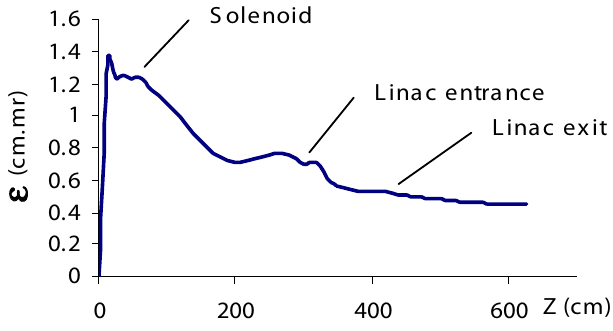
FIG. 17. Emittance ( " ) vs z of the optimized nonmagnetized